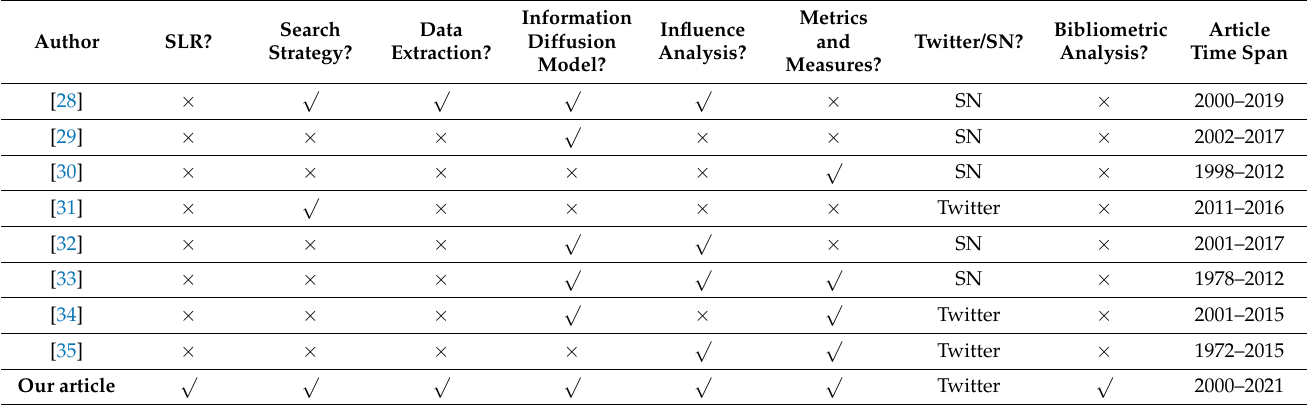
Table 1. Summary of the aspects covered in our article and in existing review